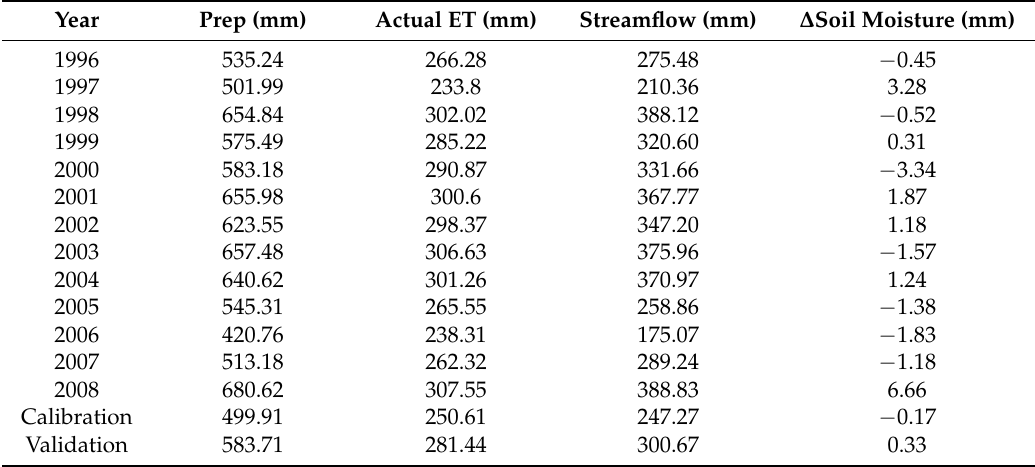
Table 8. Water balance annual from 1996 to 2008 together with that of calibration and validation periods.